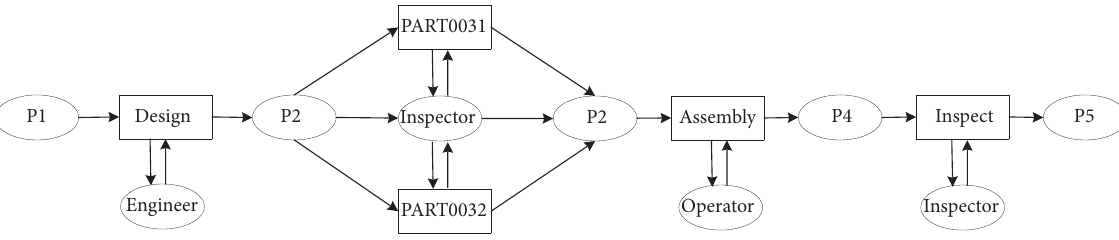
Figure 8: Subprocess CPN of CPN0012.